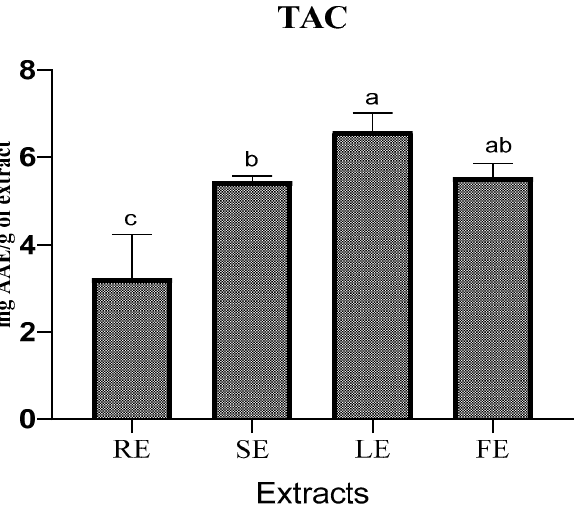
Figure 2. TAC of P. rhoeas extracts. a, b and c—values with a significant difference. Table 3. Diameter of the inhibition zone of P. rhoeas extracts and antibiotics